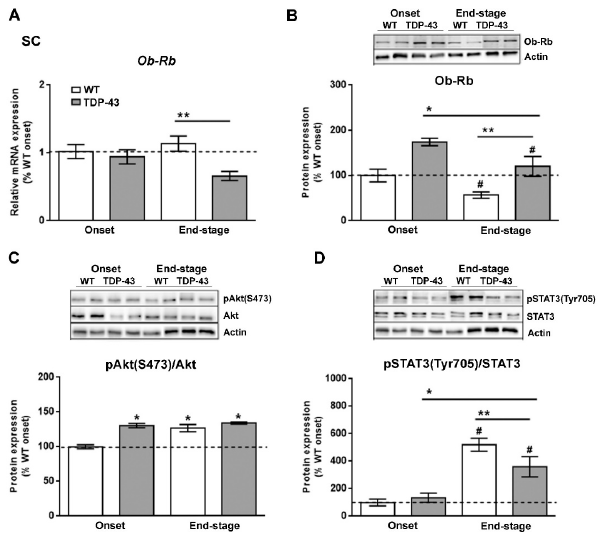
Figure 5. Alterations in tyrosine phosphorylation of STAT3 in the spinal cord of TDP-43 A315T mice. ( A ) mRNA expression of Ob-Rb receptor was assessed by RT-qPCR in TDP-43 A315T mice compared to age-matched WT littermates at both onset and end-stage of disease. Representative GAPDH-normalized immunoblot images and quantitation of ( B ) Ob-Rb receptor, ( C ) pAkt (pSer 473 -Akt) protein, ( D ) pSTAT3 (pTyr705-STAT3) protein in spinal extracts of TDP-43 A315T mice compared to age-matched WT littermates at the onset and end-stage of disease. Values are expressed as the mean ± SEM for the different groups (n = 5 per genotype/stage of disease). Comparison between groups was performed by two-way ANOVA followed by Dunnett’s post hoc test to compare all groups with WT onset stage, while Tukey’s post hoc test was used for multiple comparisons between all groups, where * p < 0.05 vs. WT onset stage; # p < 0.05 vs. TDP-43 A315T onset; ** p < 0.05 vs. WT end-staged. In the immunoblot images, representative bands were run on the same gel but were non-contiguous. Abbreviations: SC, spinal cord; Ob-Rb, long form of leptin receptor; SOCS3, Suppressor of